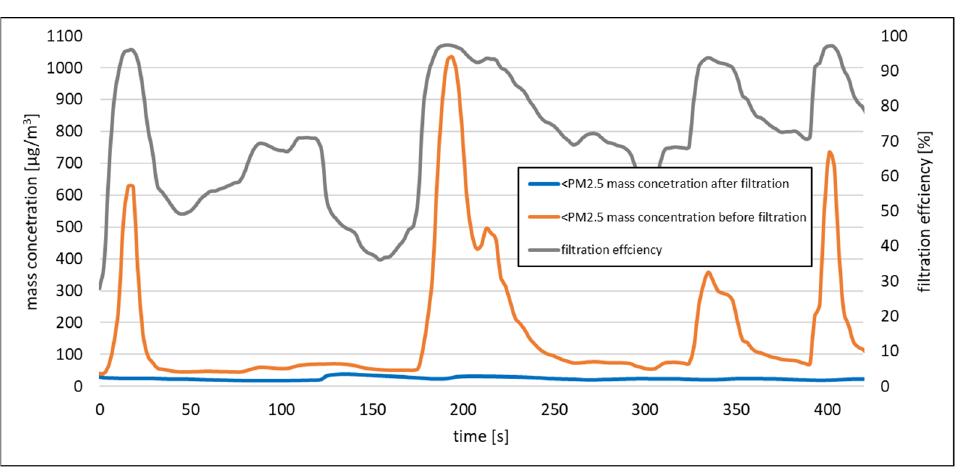
Figure 6. The change of ≤ PM2.5 mass concentration before and after filter element H13 HEPA regarding filtration efficiency (temperature: 15 ◦ C, relative humidity: